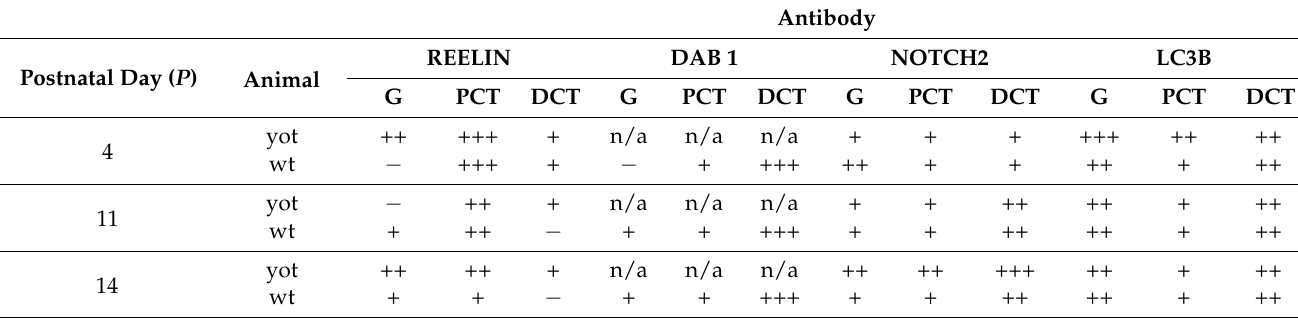
Table 2. Staining intensity of specific antibodies in the kidneys of yotari and wild-type mouse in 4P, 11P and 14P. +++— strong reactivity; ++—moderate reactivity; +—mild reactivity; − —no reactivity, n/a—not applicable; G—glomeruli, PCT—proximal convoluted tubules, DCT—distal convoluted tubules, P— days of postnatal development.